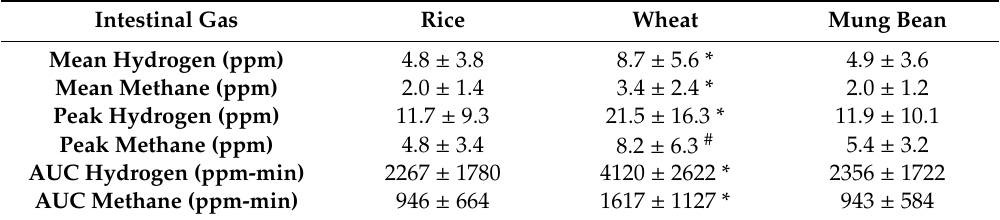
Table 2. Intestinal gas production after ingestion of study diet (rice, wheat, and mung bean noodle). Intestinal Gas